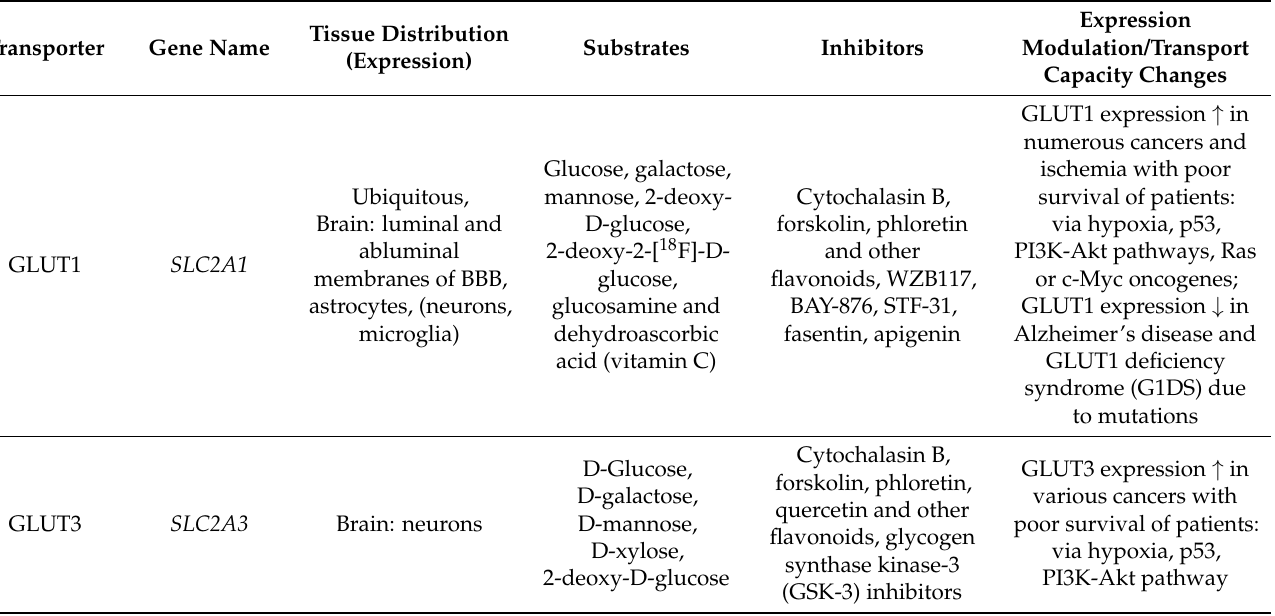
Table 2. Tissue distribution, substrates, inhibitors, and expression/function modulators of GLUT1 and